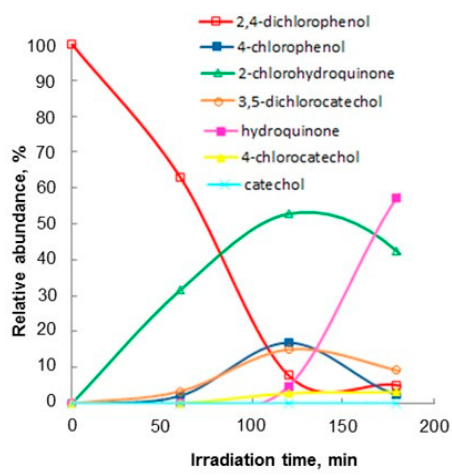
Figure 6. Intermediates identified during the photocatalytic oxidation of 2,4-dichlorophenol working solution of 300 mg O 2 /L.